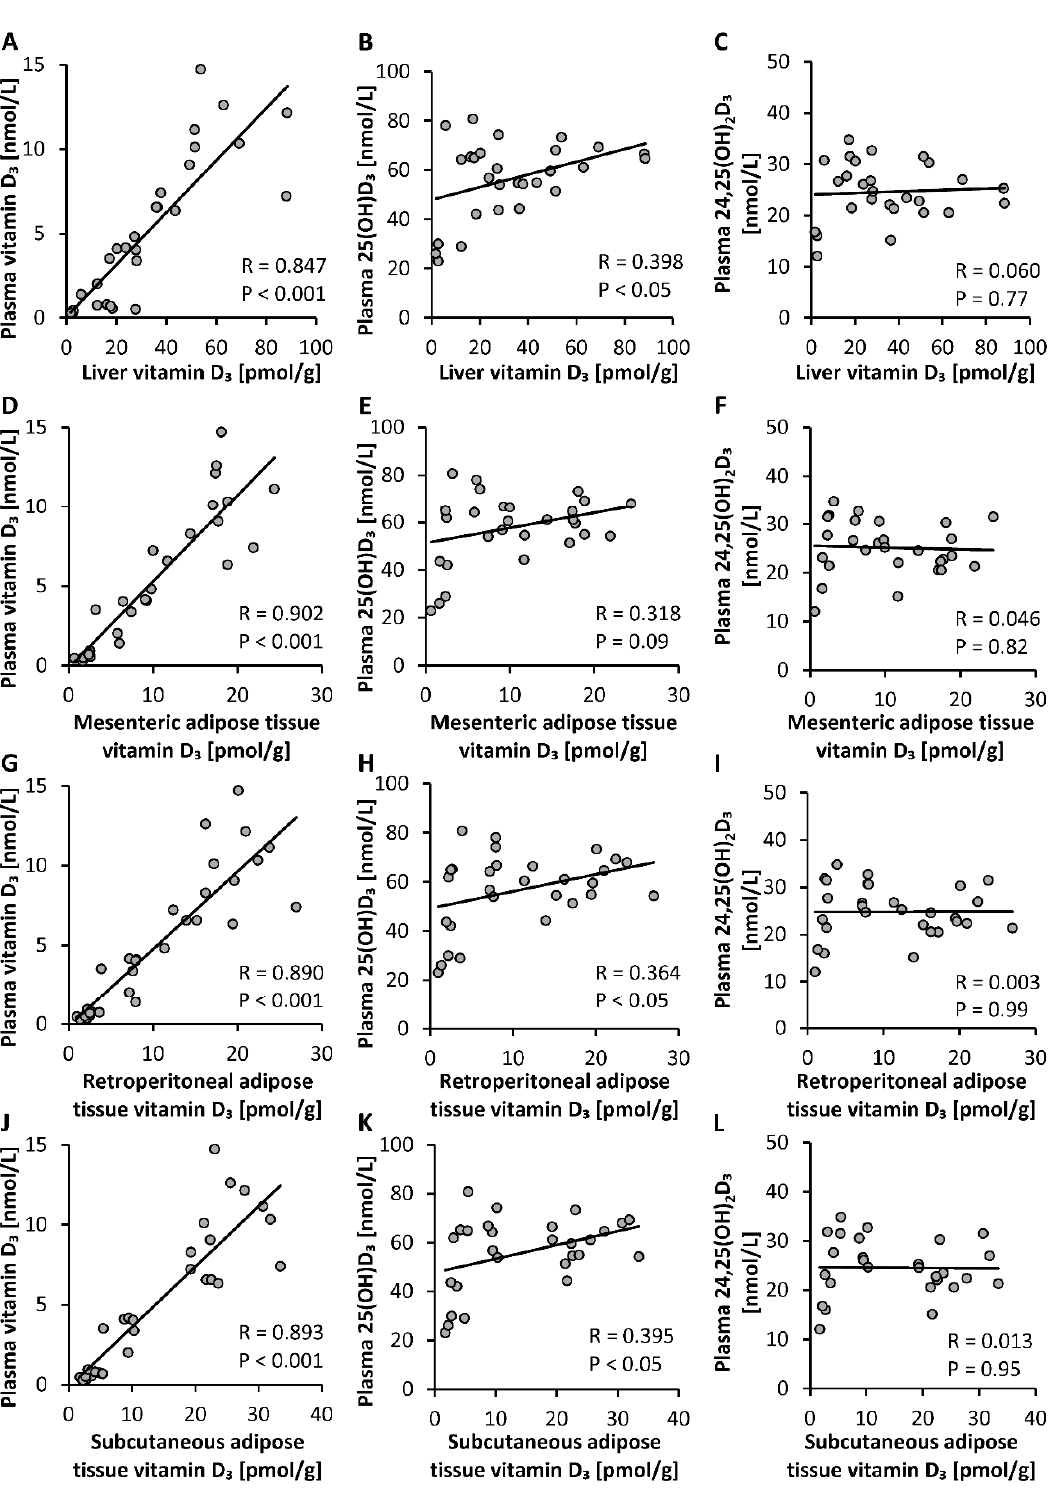
Figure 4. Correlations between concentrations of plasma vitamin D 3 metabolites and vitamin D 3 stores in the liver ( A – C ) and mesenteric ( D – F ), retroperitoneal ( G – I ) and subcutaneous ( J – L ) adipose tissues of mice that were fed diets containing 5 µ g, 10 µ g, 15 µ g, 20 µ g, 25 µ g, 30 µ g, 35 µ g, 40 µ g, 45 µ g or 50 µ g vitamin D 3 per kg of diet for three weeks ( n = 3). 25(OH)D 3 , 25-hydroxyvitamin D 3 ; 24,25(OH) 2 D 3 , 24,25-dihydroxyvitamin D 3 ; R, correlation coefficient.